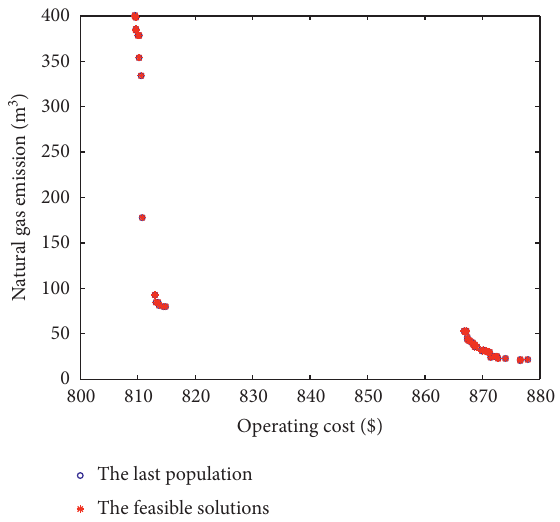
Figure 4: The Pareto set obtained by IHCHS-NSGAII.